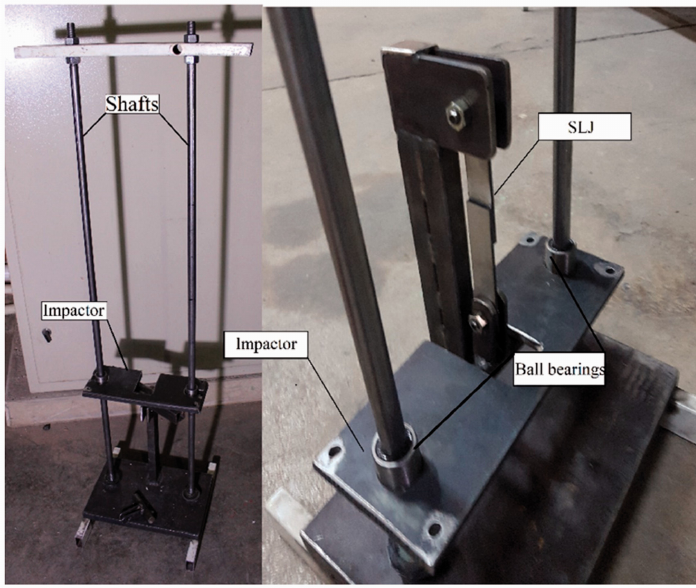
Figure 3. The device used to apply the impact loads (already developed and used by authors